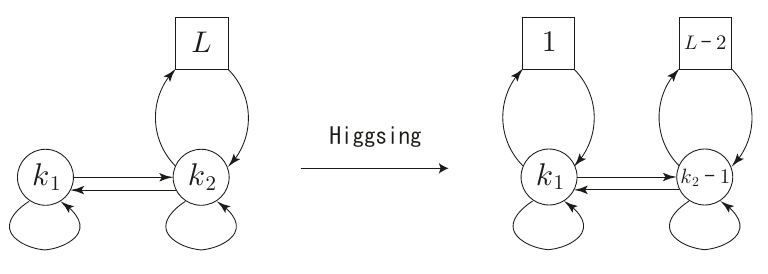
Figure 6 . Higgsing the A 2 linear